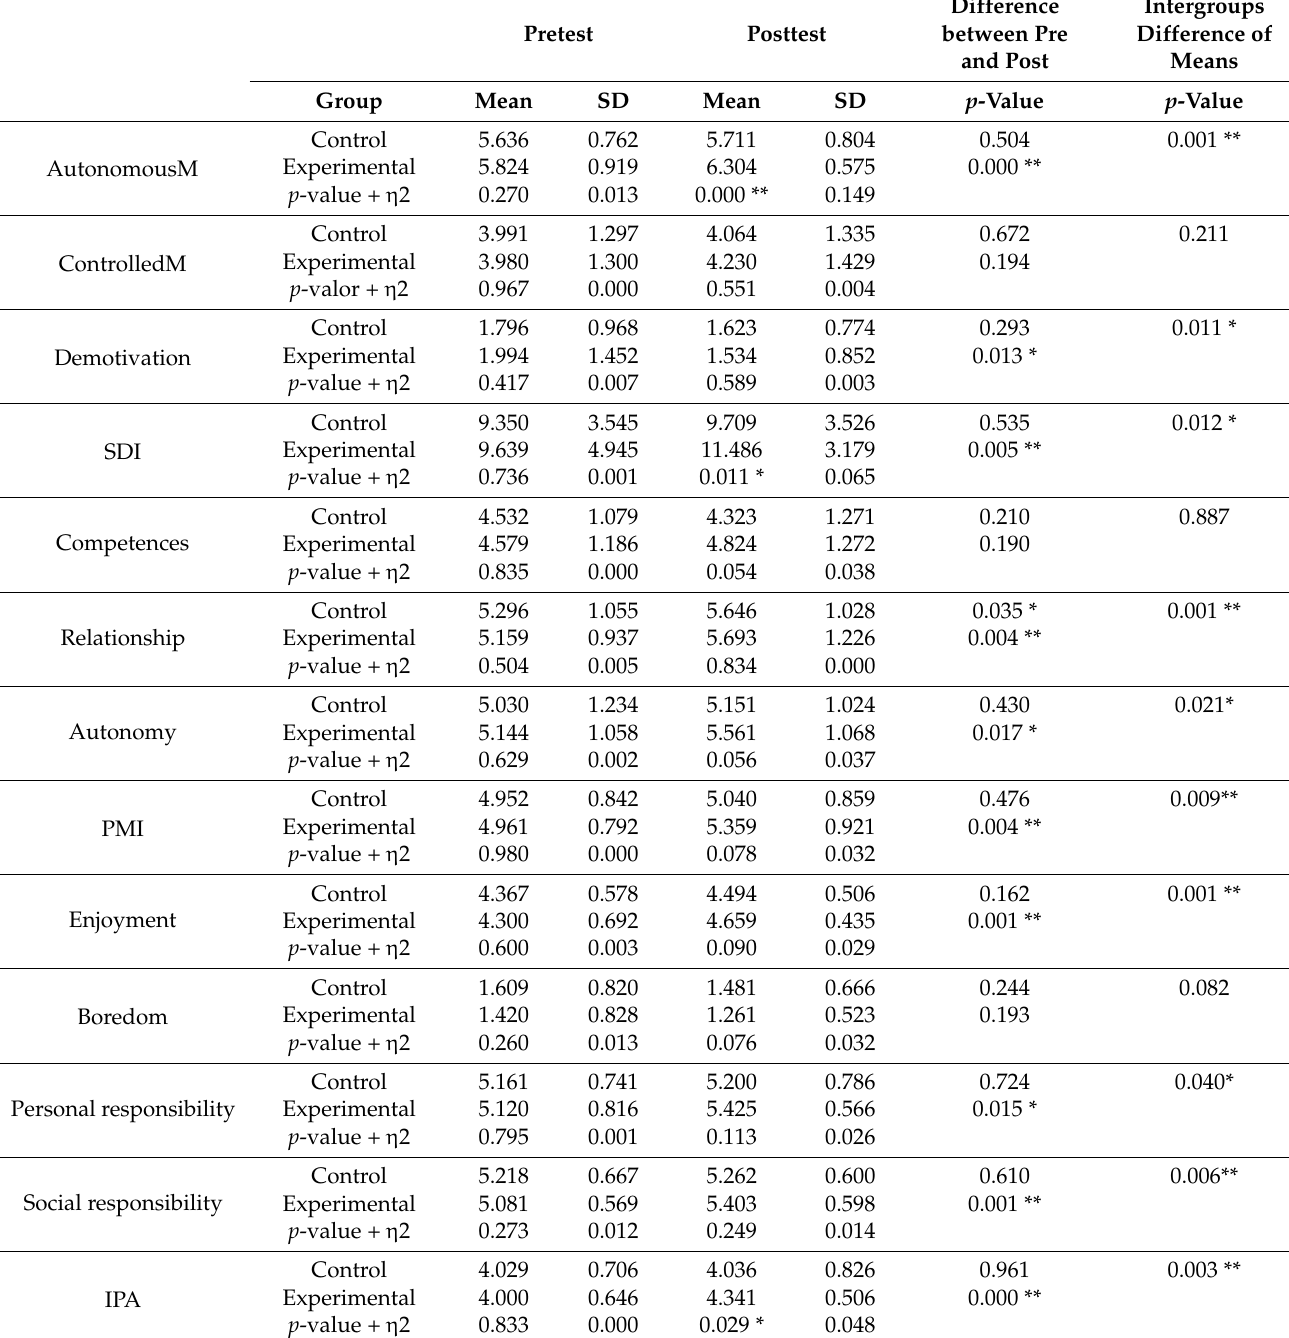
Table 3. Multivariate analysis of the intervention (MANOVA). Pretest Posttest